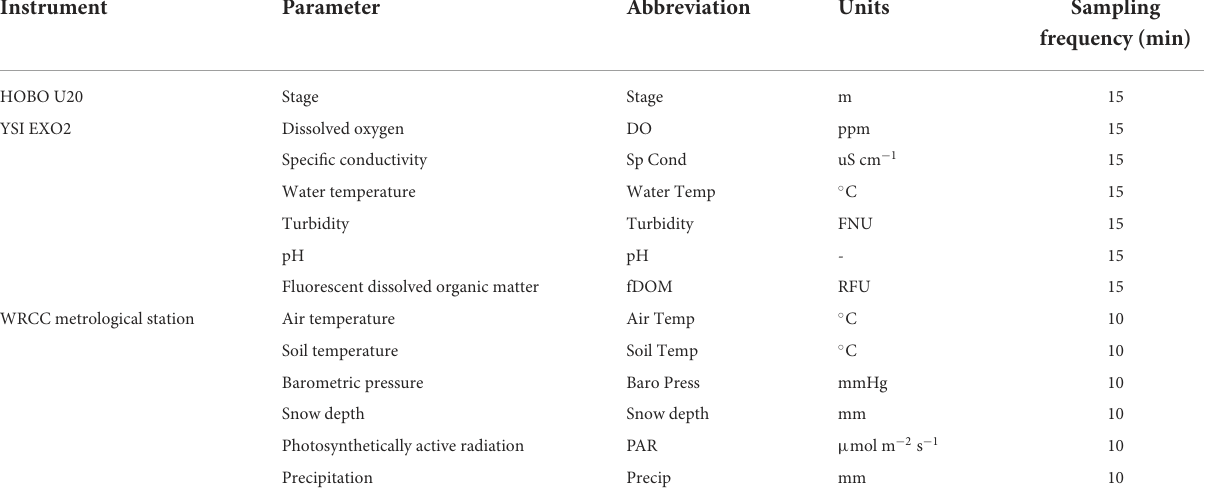
TABLE 1 Parameters and corresponding sensors and sampling frequencies available in our study between the fall and spring seasons of 2018–2019 and 2020–2021.